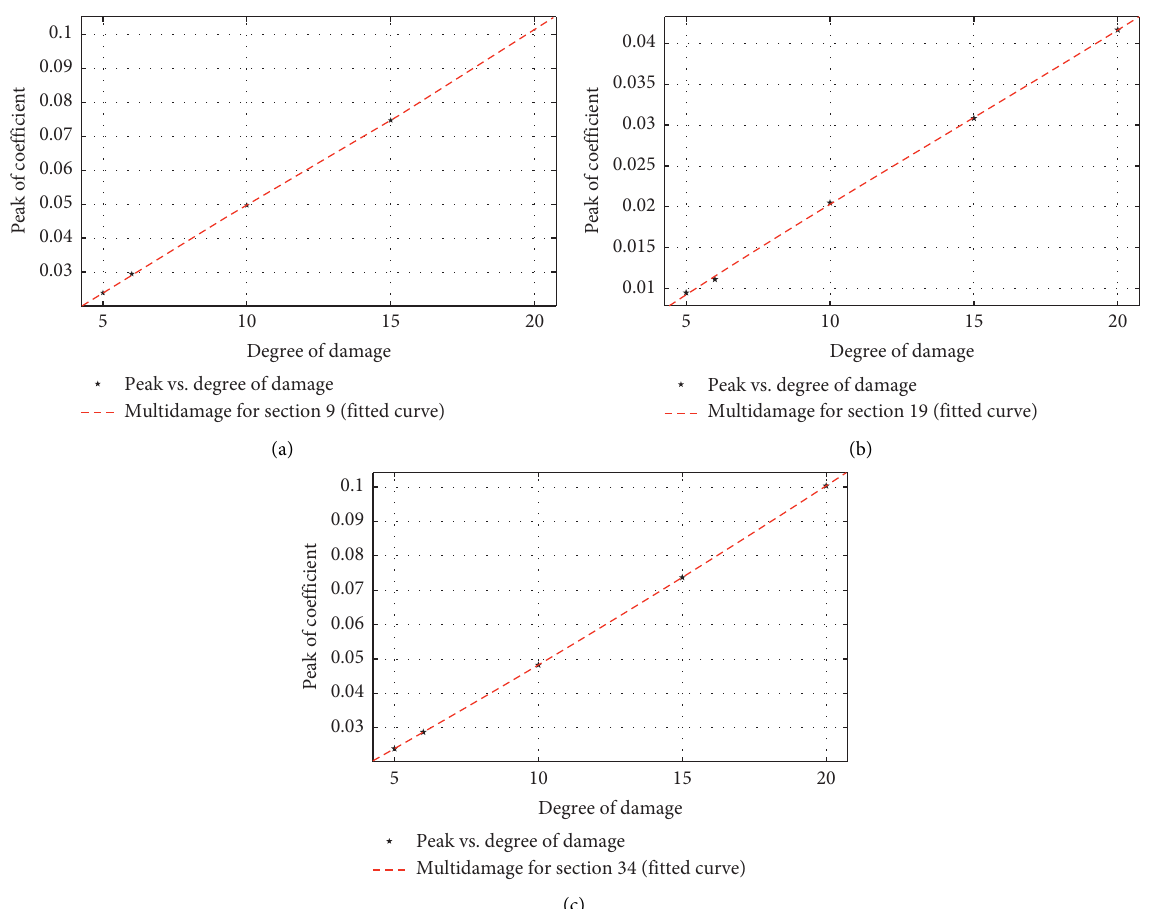
Figure 17: Fitted curves at multiple damage levels. Multidamage fittings for sections (a) 9, (b) 19, and (c)